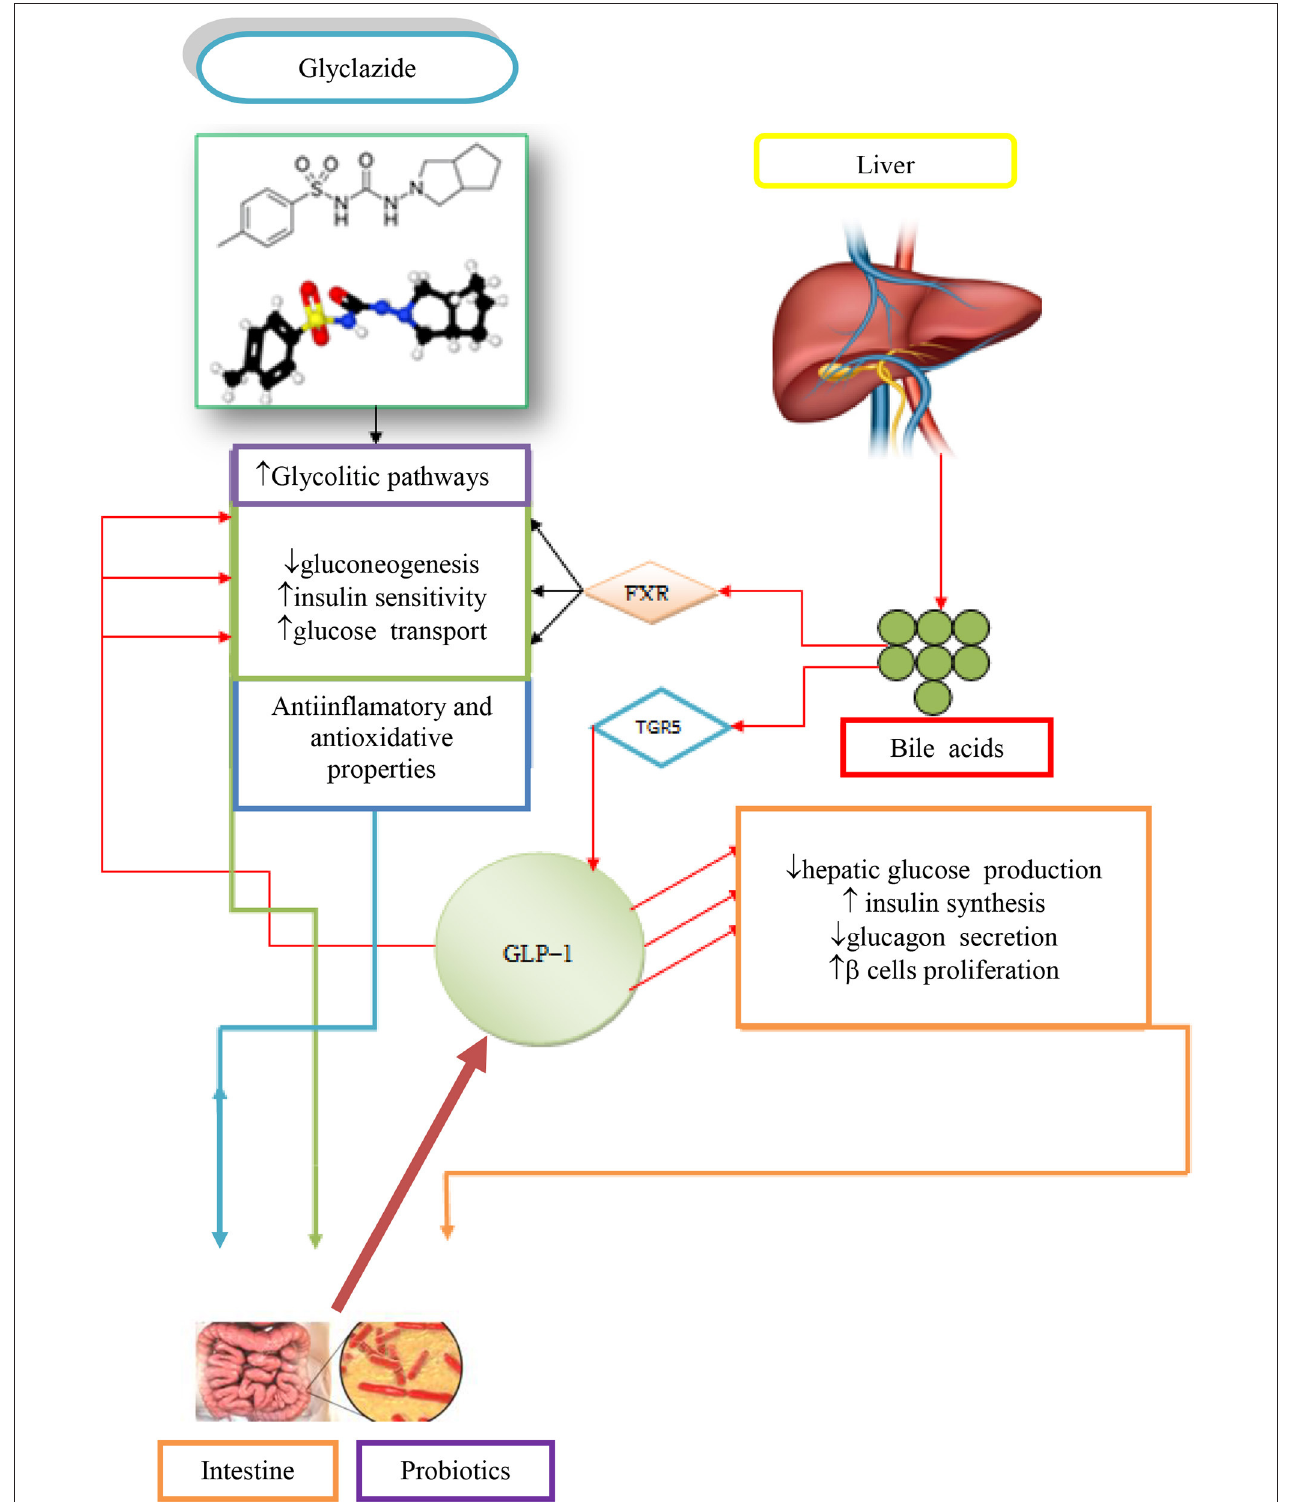
FIGURE 2 | Potential synergistic effects due to concomitant administration of gliclazide, BAs and probiotics in treating T1D (Mikov et al., 2017).